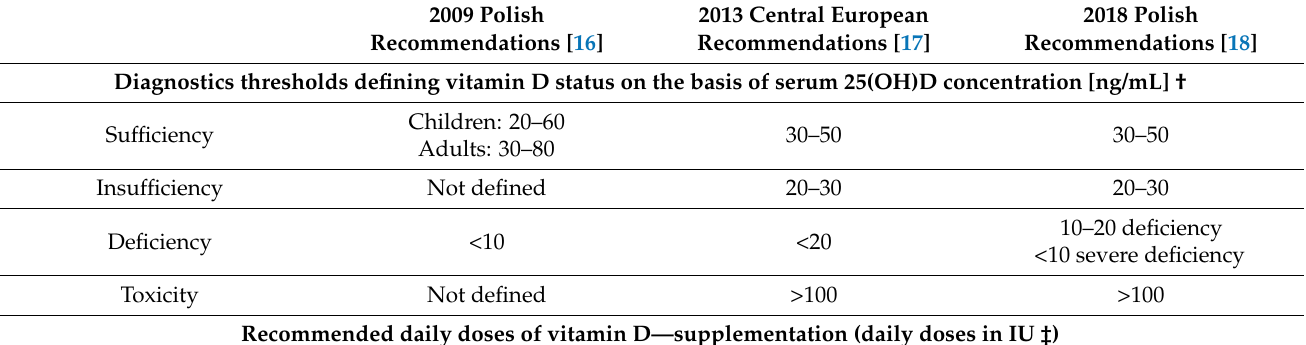
Table 1. Summary of previous vitamin D supplementation guidelines for Poland and Central